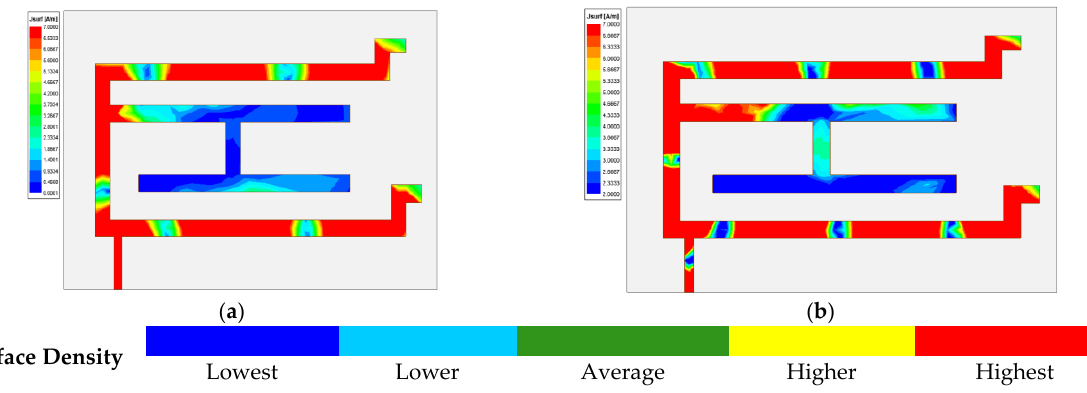
Figure 8. Current density at ( a ) 3.63 GHz and ( b ) 4.94 GHz frequencies.